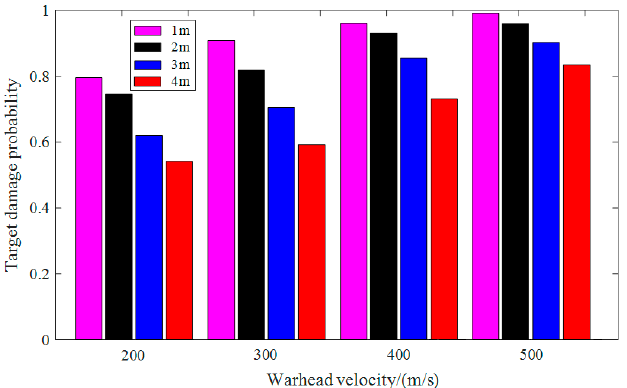
Figure 6. Variation curve of target damage probability with warhead flight velocity.